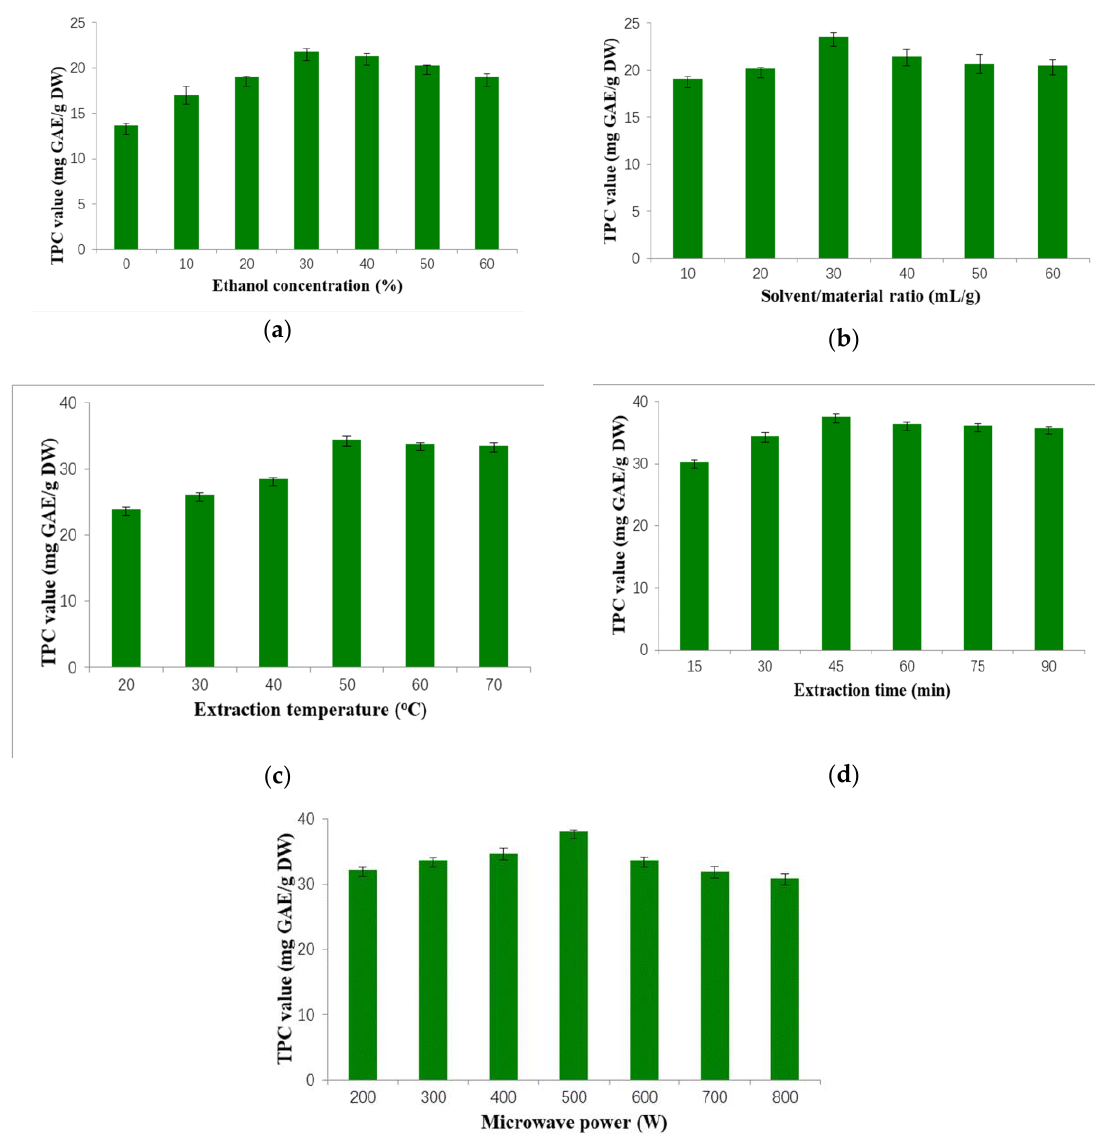
Figure 1. Effects of different factors on total phenolic content value of extracts (mg GAE/g DW): ethanol concentration (%) ( a ); solvent/material ratio (mL/g) ( b ); extraction temperature (°C) ( c ); extraction temperature (min) ( d ); and microwave power (W) ( e ). TPC: total phenolic content; GAE: gallic acid equivalent; DW: dry weight.